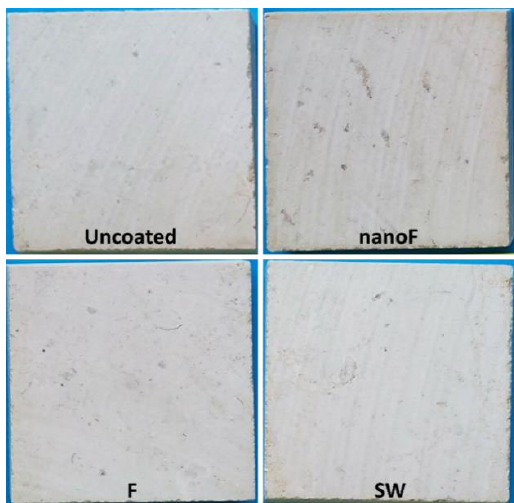
Figure 6. Uncoated and coated CS stone surfaces.